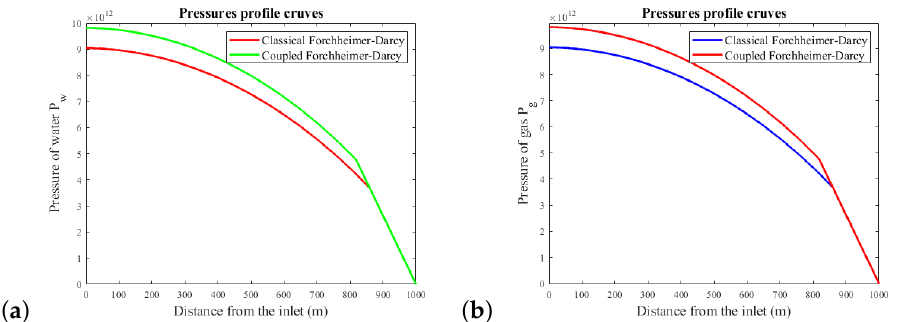
Figure 4. One-dimensional linear water pressure flow p w and gas pressure p g after 1000